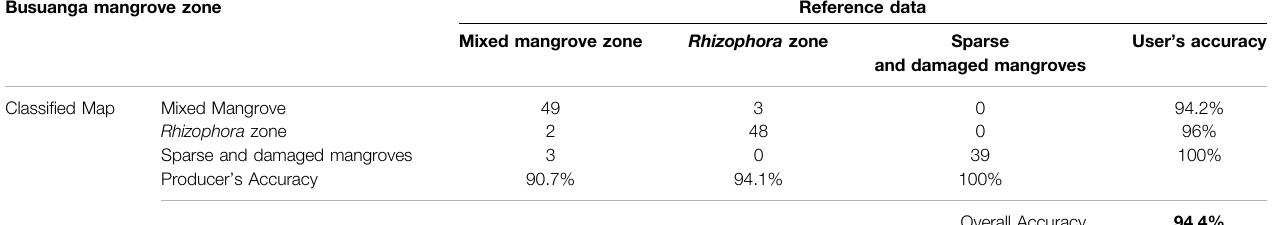
TABLE 5 | Classi fi cation confusion matrix of mangrove zonation outputs in Coron and Busuanga, Palawan using the zonation mapping work fl ow with input Sentinel-2 derived water, vegetation, and biophysical dataset. Busuanga mangrove zone